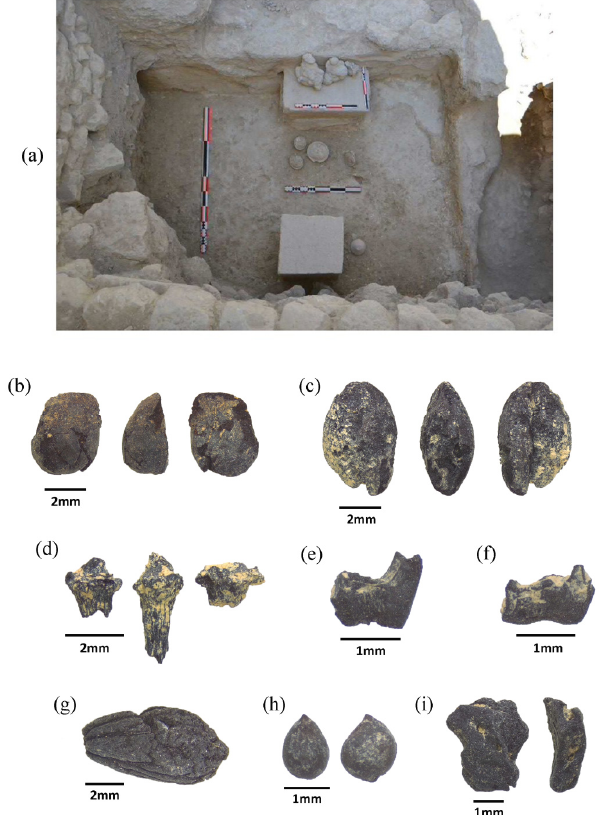
Figure 5. Plant remains from the Fetish Shrine at Knossos Anetaki: ( a ) view of West half of the Main Chamber of the Fetish Shrine; ( b ) grass pea ( Lathyrus sp.) cotyledon; ( c ) barley grain ( Hordeum vulgare cf. hulled); ( d ) grape ( Vitis vinifera ) stems; ( e ) emmer ( Triticum turgidum subsp. diococcum ) spikelet; ( f ) einkorn ( Triticum monococcum ) spikelet; ( g ) whole olive stone ( Olea europaea ); ( h ) fig seed ( Ficus carica ); ( i ) almond ( Amygdalus communis ) shell fragment.